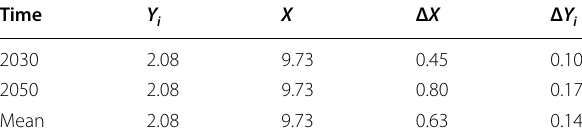
Table 7 Estimation of environmental change index (Δ Y and its components for proposed greenbelt plan based on two development probabilities in future